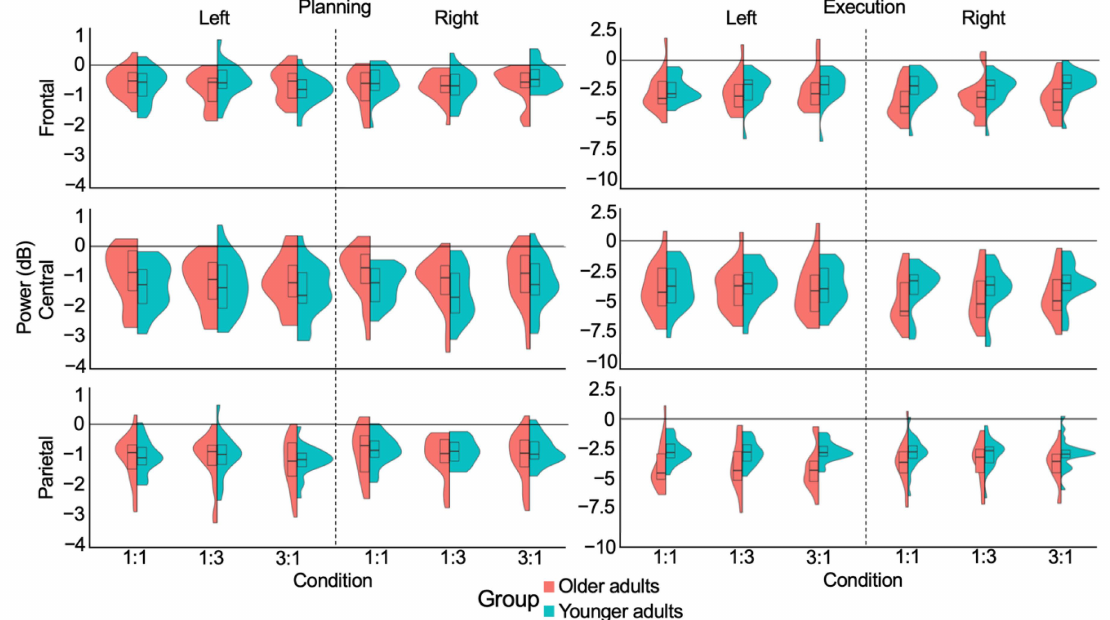
Figure A1. Grand-average time-frequency mask obtained by averaging the power values per time- and frequency-point, across all participants, electrodes and BTT conditions. This mask was used for power value extraction. Specifically, the mean beta power value within the black contours was extracted per participant, electrode and BTT condition and used in the statistical analyses. The black contours were defined by a statistical masking procedure (cf., Section 2.5.2. Effect of age, hemispheric laterality, and complexity on MRBD during bimanual planning and execution (Hypotheses 2–4)). Colors denote spectral power, with dark blue and red being − 3 and 3 dB, respectively.